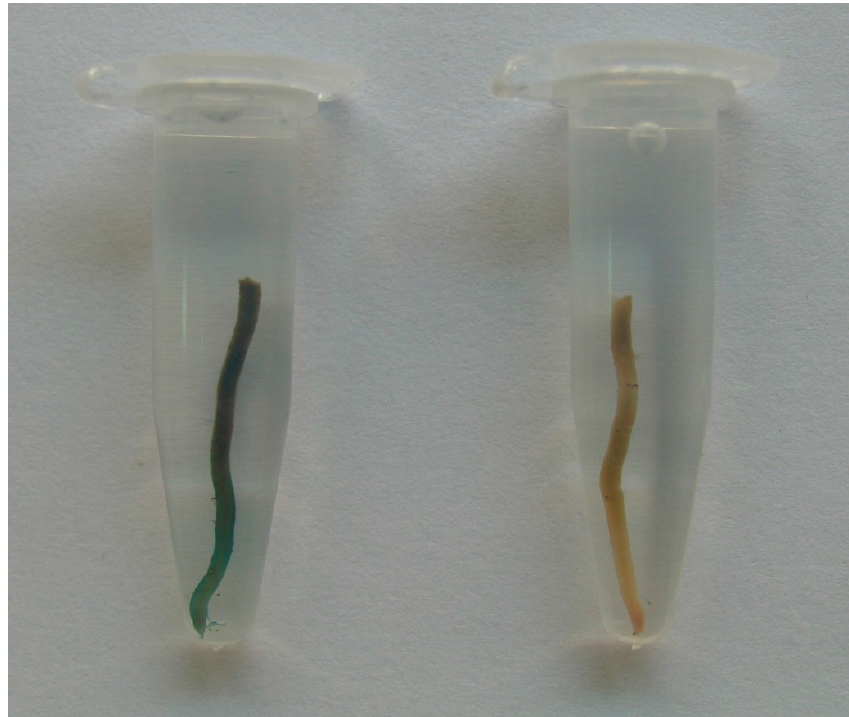
Figure 3. Histochemical GUS assay in roots of pear seedlings.